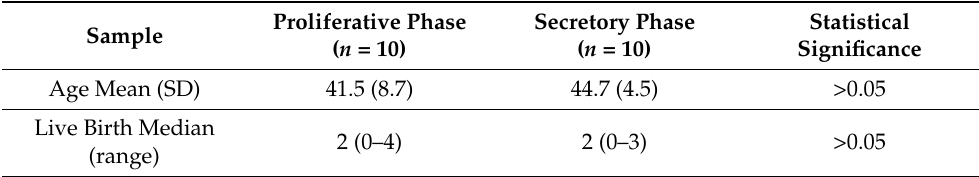
Table 1. Demographics, cohort 1.